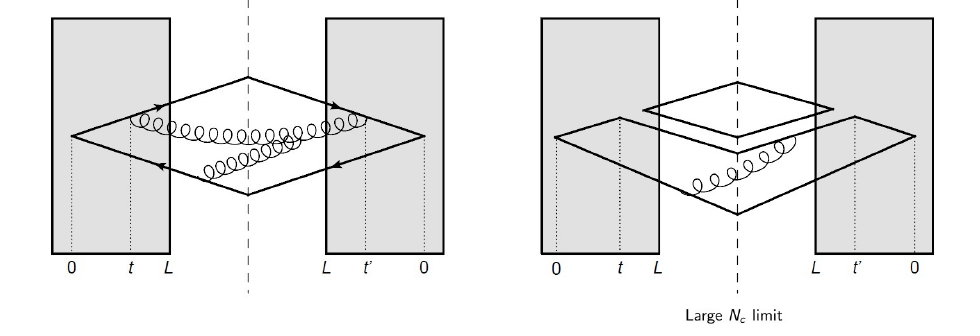
Figure 1. Interference term for the case of three emitters—soft gluon radiation off a radiated gluon in conjugate amplitude. The spectrum is proportional to S ( 0, t ) S ( t , t (cid:48) ) : if coherence is destroyed after the very first hard splitting—Region I, between (0,t)—decoherence will govern over the entire cascade